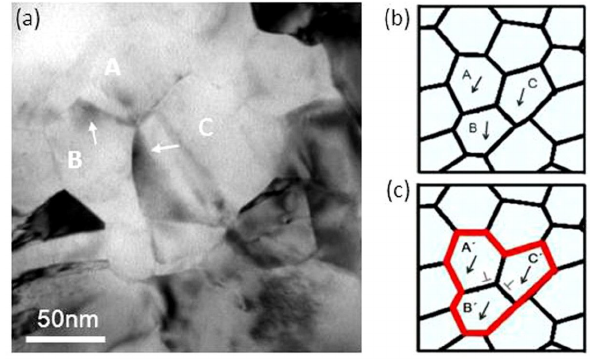
Figure 1: (a) Typical bright-field TEM image showing three grains, labeled as A, B, and C, in the cold-rolled NC Ni sample. Some trace of dislocation motion is shown in grains bywhite arrows. The corre- sponding schematic diagrams of grain coalesce by grain rotation and dislocation motion are shown in (b) and (c). The orientation of grains is indicated by black